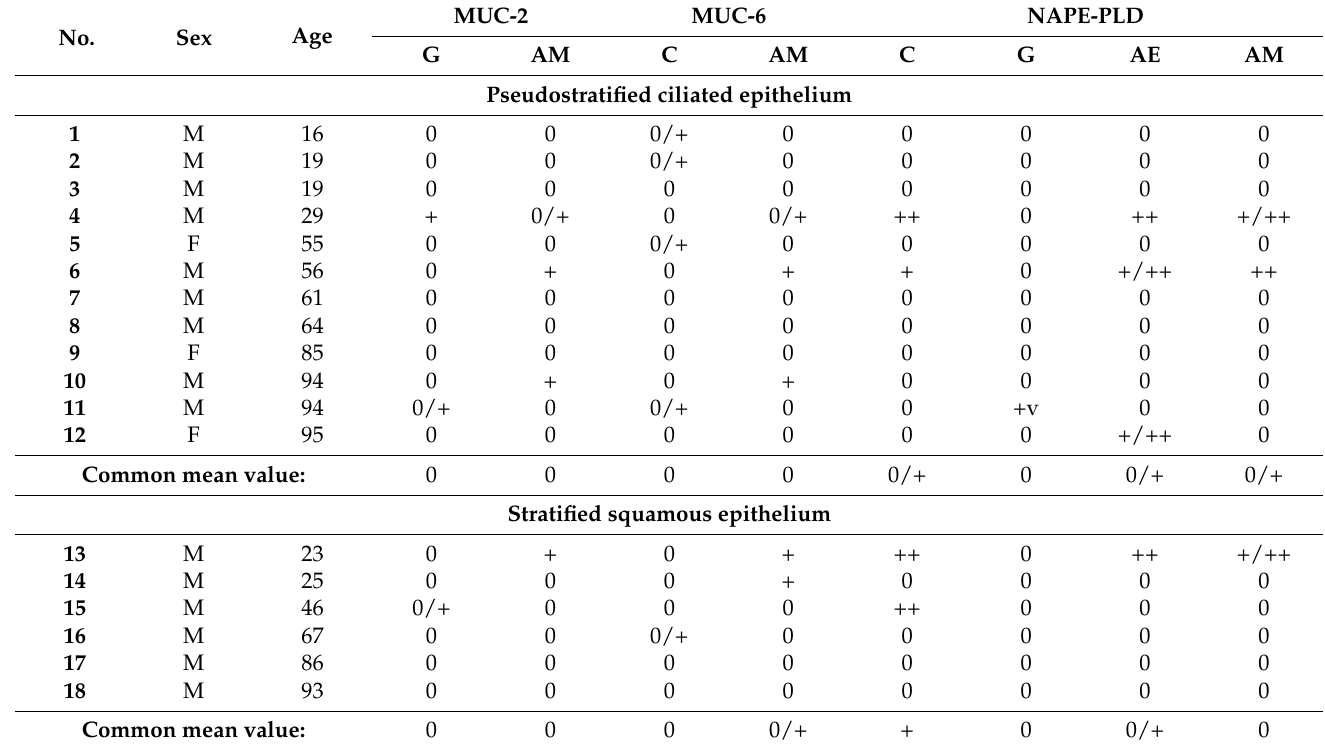
Table 1. Relative number of MUC-2, MUC-6 and NAPE positive structures in the pseudostratified ciliated epithelium and squamous stratified